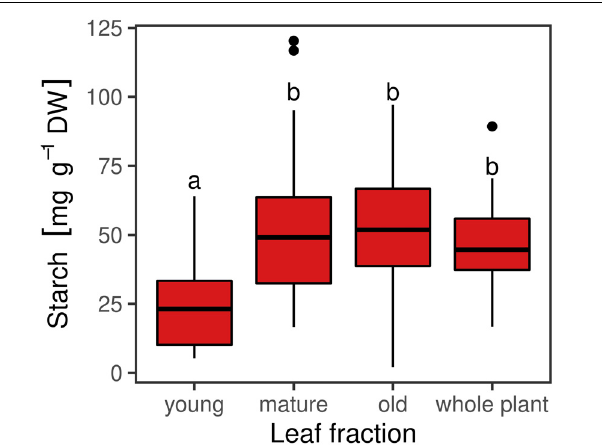
FIGURE 4 | Starch concentrations in different leaf fractions [young ( n = 35), mature ( n = 108), old ( n = 36)] and whole plants ( n = 48) of red clover genotypes harvested at the end of the day (ED). Horizontal bars represent medians. Medians with no letter in common are significantly different (Kruskal-Wallis; α =